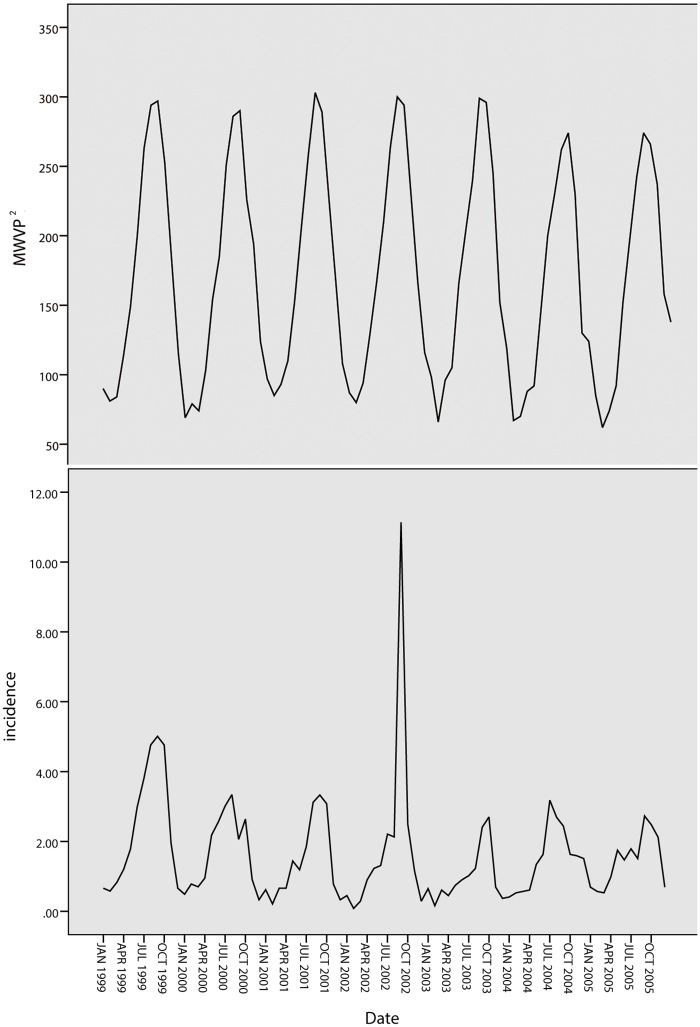
Tendencies of BD incidence and MWVP2 in Quzhou.